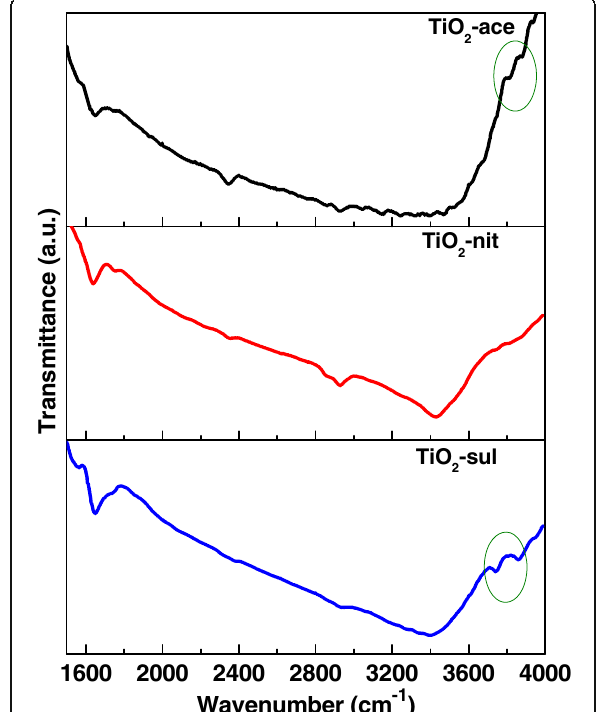
Fig. 6 FTIR spectra of the calcined TiO 2 samples